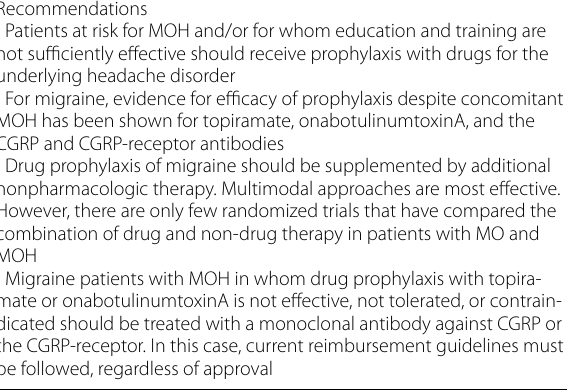
Table 1 Success rates in studies of education or training as therapy or part of a therapeutic approach (MOH overuse